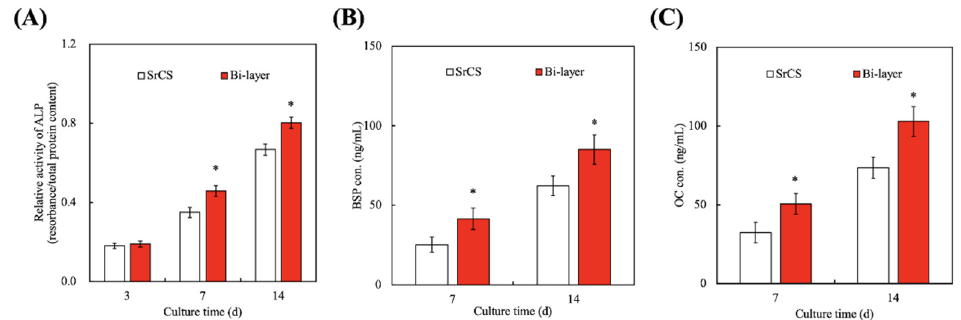
Figure 8. ( A ) The ALP, ( B ) BSP, and ( C ) OC proteins expression of WJMSCs cultured on SrCS and bi-layer scaffolds for different time-points. Data presented as mean ± SEM, n = 6 for each group. * indicates a significant difference ( p < 0.05) when compared to SrCS.